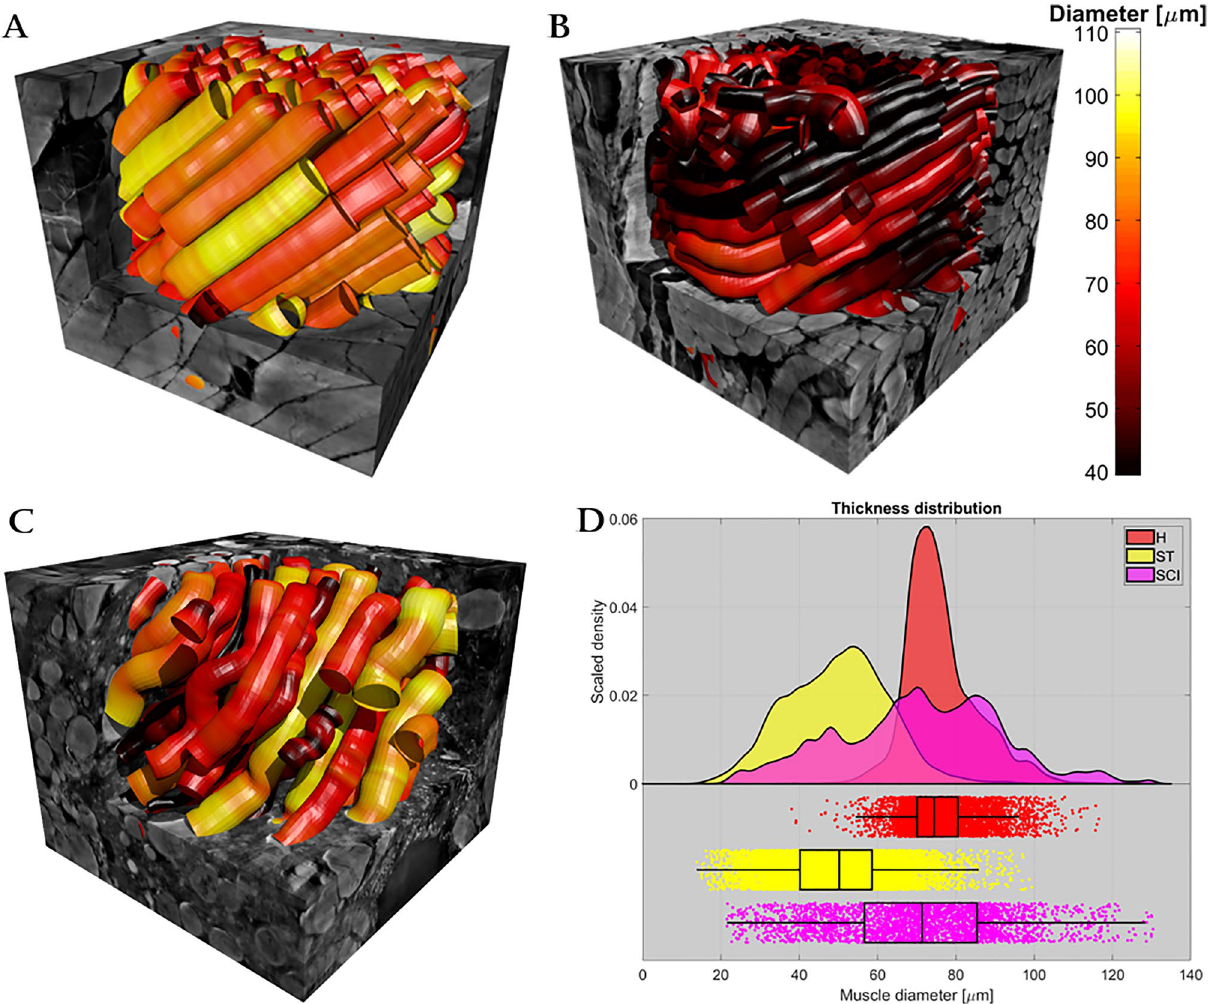
Figure 5. Analysis of local thickness. ( A – C ) The surface of segmented muscle cells within each of the three sample volumes, respectively in ( A ) the healthy control sample (H), in ( B ) the stroke sample (ST), and in ( C ) the spinal cord injury (SCI) sample. The segmentation surfaces are colored according to the local equivalent diameter using the given color bar. ( D ) The statistics of local fiber diameter for each sample. The distributions are a result of kernel density estimation. The boxplots indicate median value, 1 st and 3rd quartile, and the whiskers are 1.5 IQR or truncated at extremum value. The figure was created using MatLab software (v2020b): https:// www. mathw orks. com/ produ cts/ new_ produ cts/ relea se202 0b. html and Blender software (v2.78c): https:// www. blend er. org/ downl oad/ relea ses/2-